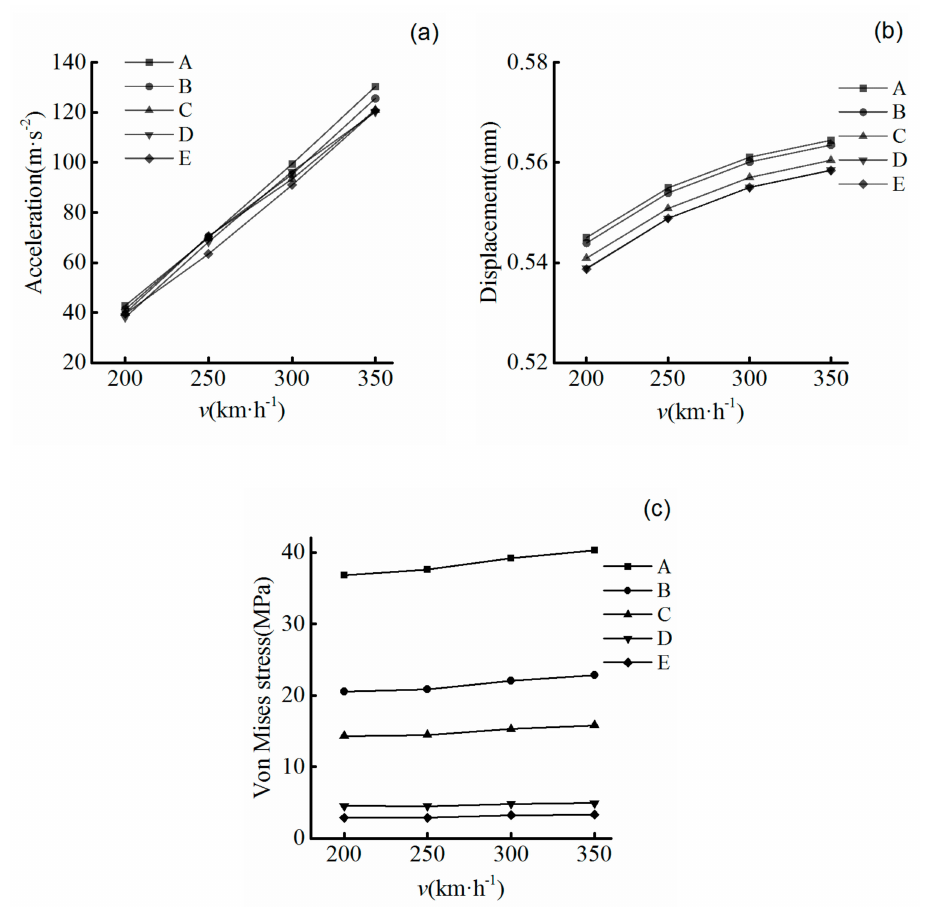
Figure 14. E ff ects of running speed on rail dynamics: ( a ) vibration acceleration versus running speed; ( b ) vibration displacement versus running speed and ( c ) von Mises equivalent stress versus running